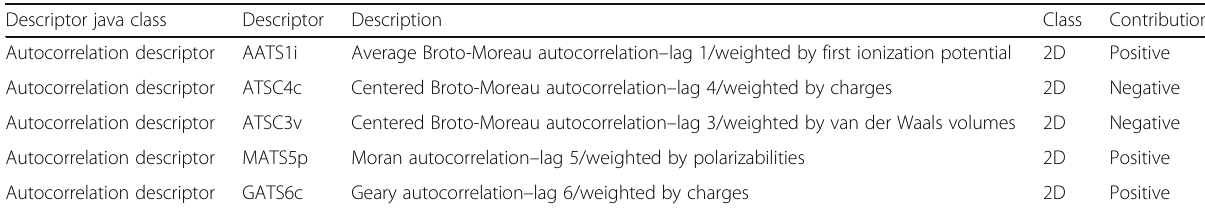
Table 6 Definition of the descriptors in the QSAR model 1